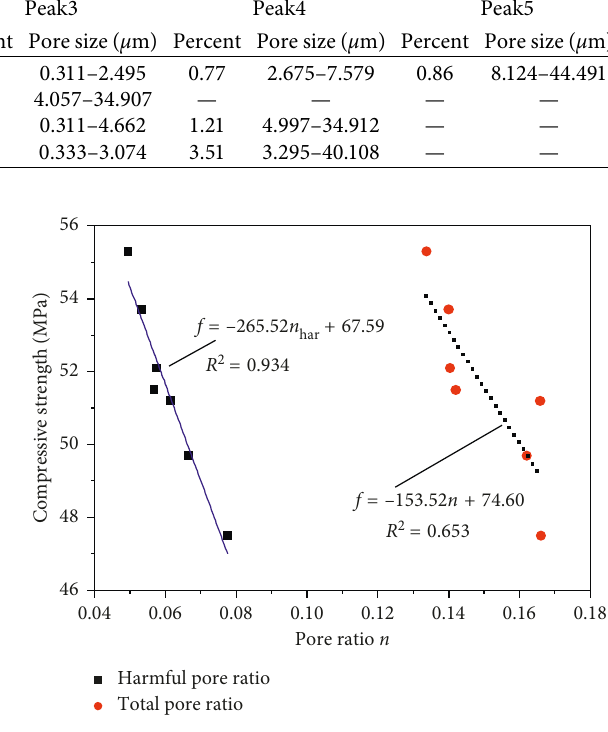
Figure 9: Classification of concrete pore size.